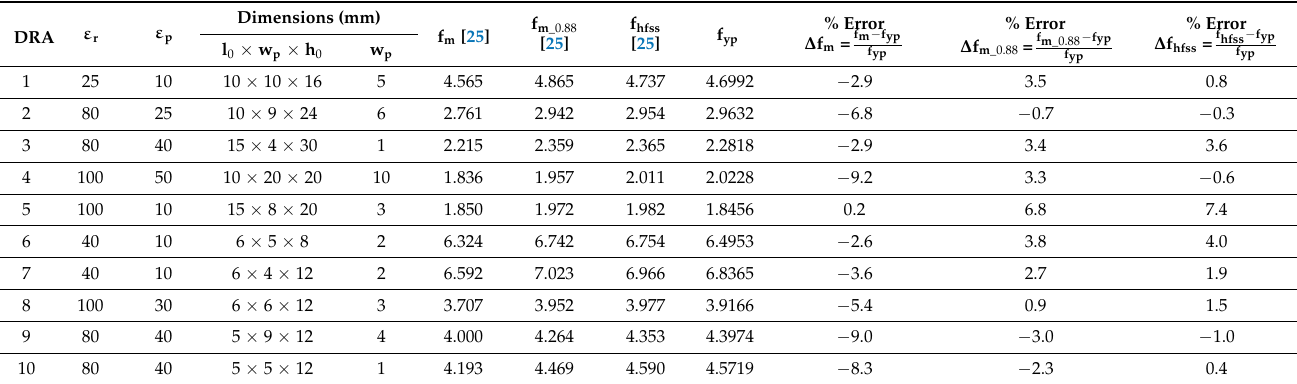
Table 1. Comparison of resonant frequencies with the mode matching theory and the simulated resonant frequencies of a horizontally inhomogeneous rectangular dielectric resonator antenna (HIRDRA) (Table 1 [25]).